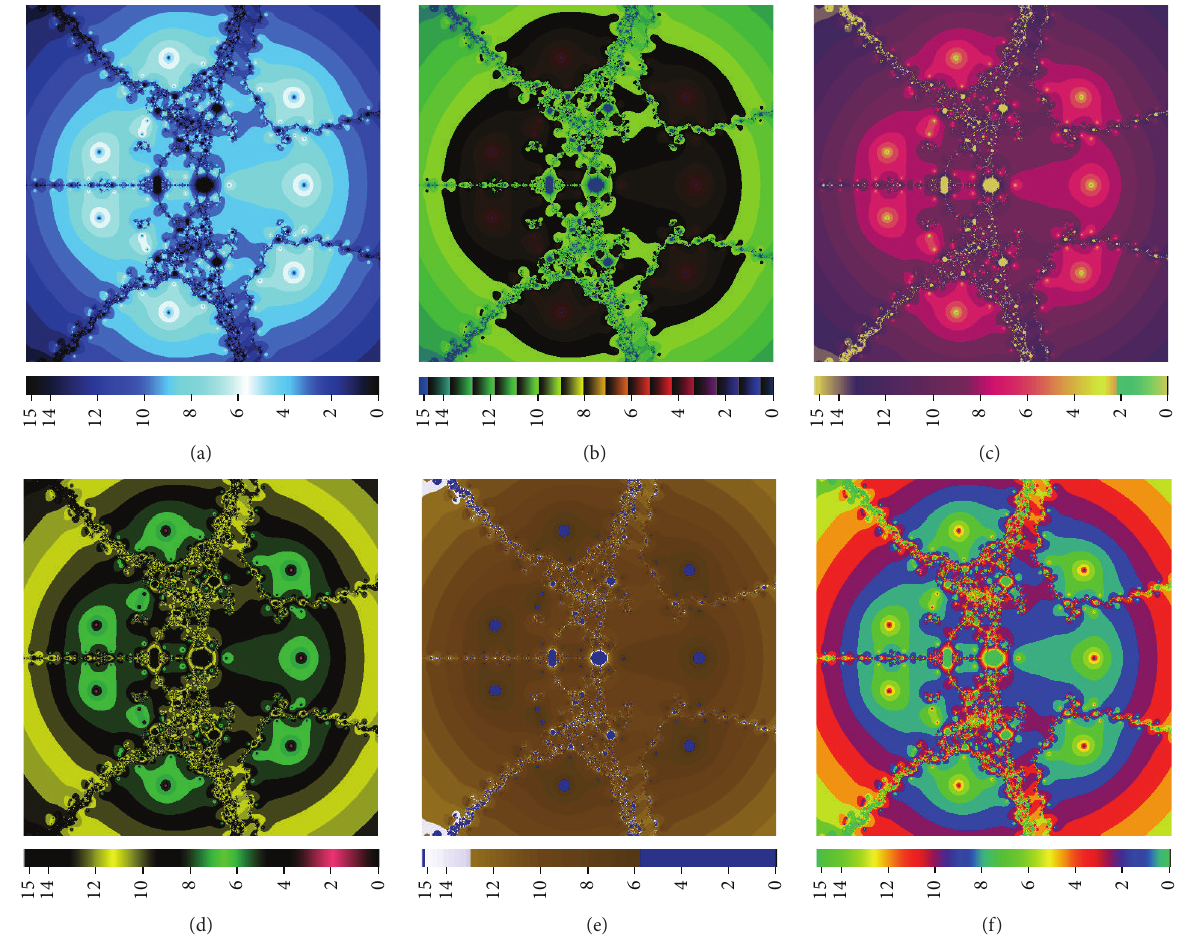
Figure 8: Examples of different colour maps application for the fixed